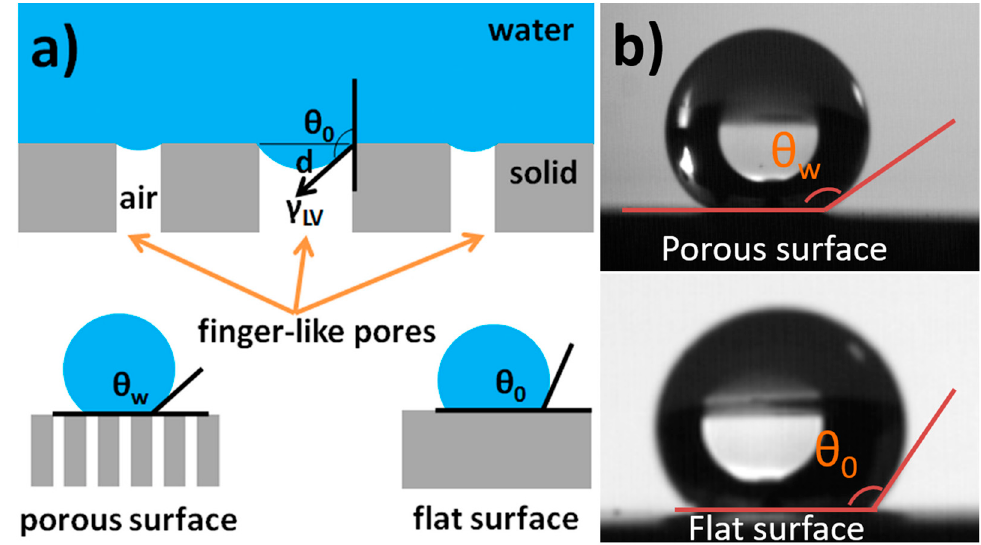
Figure 4. ( a ) Illustration of the calculation of theoretical water intrusion pressure of FAS-grafted membrane. θ w and θ 0 are the apparent water contact angle on a porous hydrophobic surface and a flat hydrophobic surface, respectively. ( b ) Photographs of a water droplet (5 µ L) on the as-prepared porous hydrophobic surface (polished, FAS-grafted) and flat hydrophobic surface (unpolished, FAS-grafted). θ w was ~146° and θ 0 was ~131° in our case.